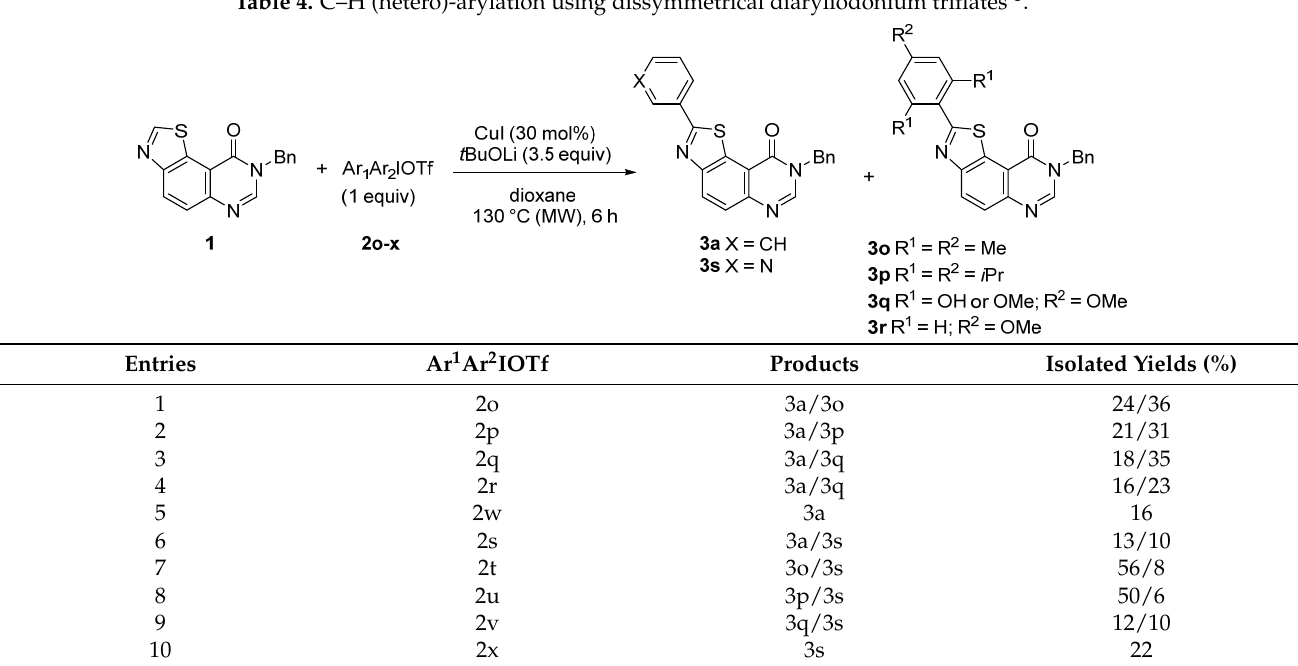
Table 4. C–H (hetero)-arylation using dissymmetrical diaryliodonium triflates 1 .